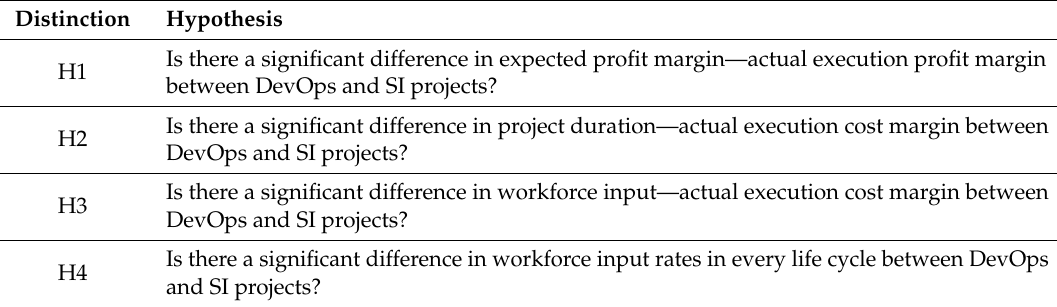
Table 8. Formulation of hypotheses.